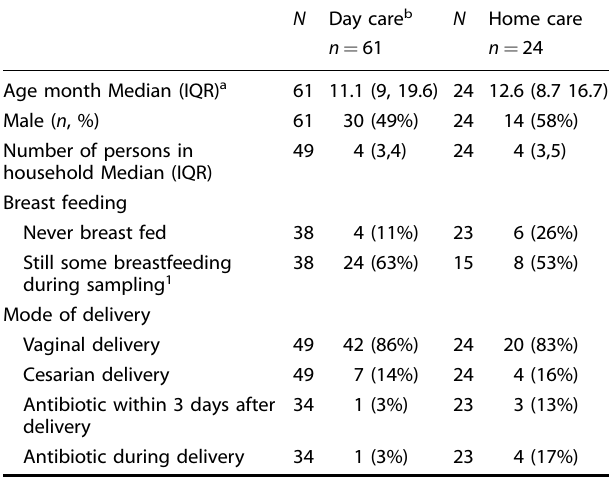
Table 1. Cohort demographics and